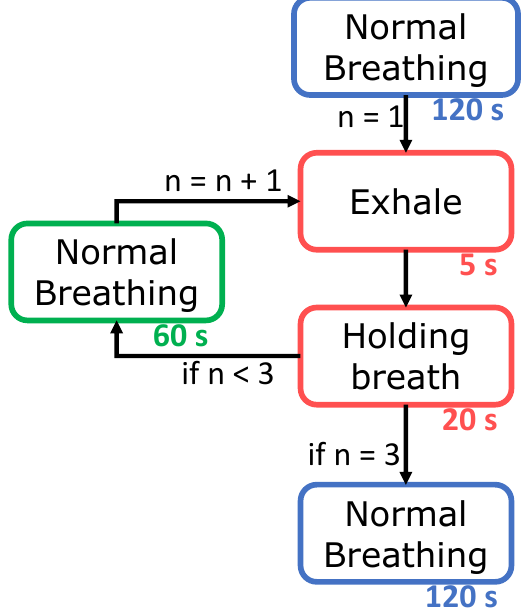
Figure 3. Flow diagram of the experiment, outlining the sequence of participants’ breathing. The duration of each stage is provided beneath in seconds. The exhale and breath holding stages are repeated three times, the 60 s normal breathing is repeated twice, and 120 s of normal breathing occurs both at the start and at the end of the